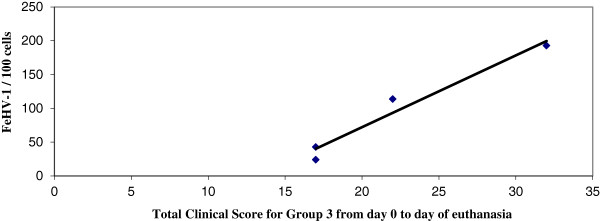
Clinical score versus FeHV-1 copy number within the trigeminal ganglia (TG). Linear regression of the total clinical score for group 3 from day 0 to the day of euthanasia compared to the FeHV-1 copy number per 100 cells within the TG. A close linear relationship was seen between the amount of latent virus present within the TG and the total clinical score for each individual animal in group 3. The p-value was 0.021 and R2 was 0.9583.